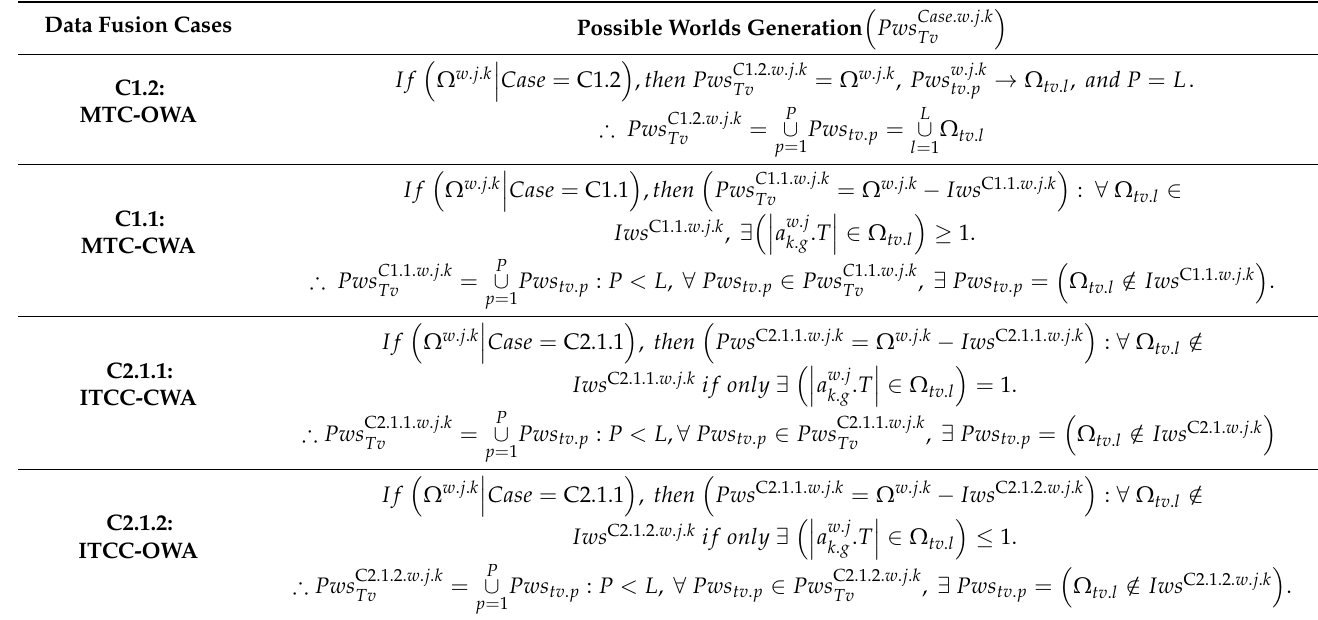
Table 4. The possible-worlds generations given a data fusion